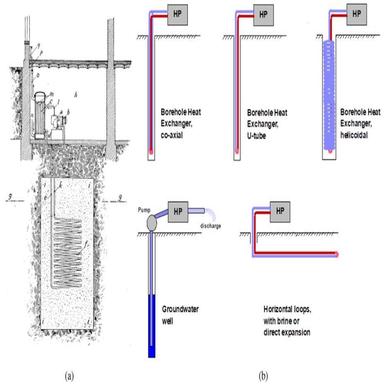
At left (a)Ground Source Heat Pump in Swiss Patent 59350 of 1912 (inventor H. Zoelly); at the right (b) Ground-coupling methods listed by Ref. , re-drawn and harmonized as in.